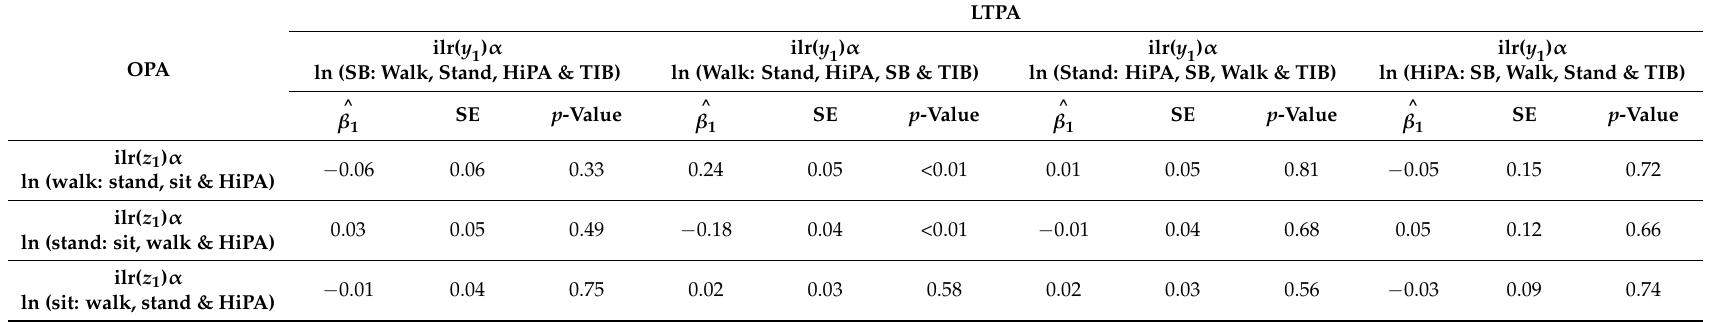
Table 4. Compositional analysis of the association between ilr-coordinates of OPA and LTPA subcompositions among men (N = 495).